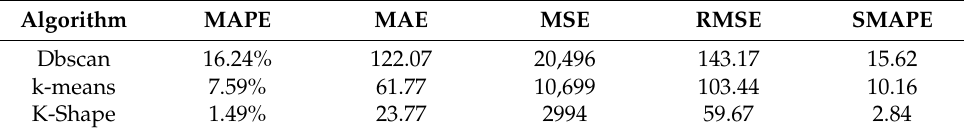
Table 2. Cluster comparison experimental